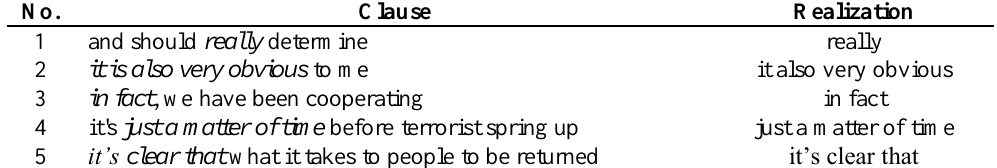
Table 6. Heteroglossic - Expansion – Attribute - Acknowledge (HEAA)